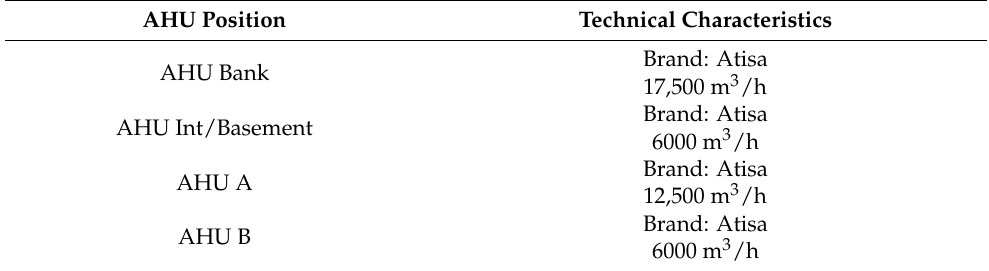
Table 2. AHU position and